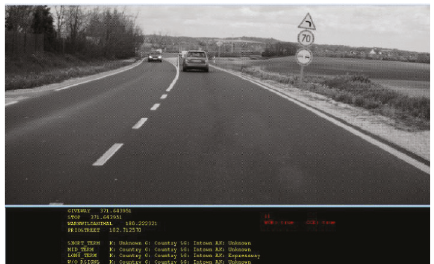
Figure 5: Screenshot showing a road location on a country road in Hungary.